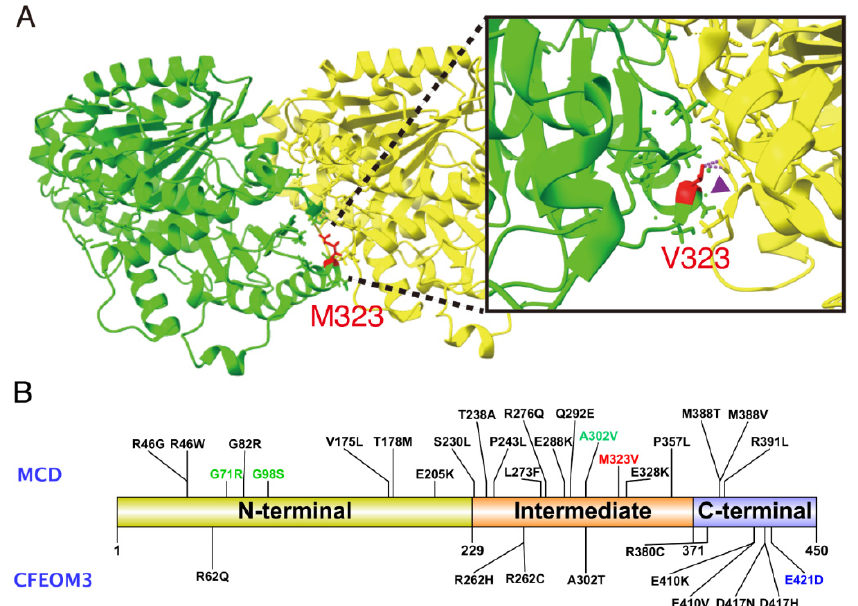
Figure 3. ( A ) A protein model with UCSF ChimeraX, showing the unstable formation of αβ tubulin heterodimer in M323V syndrome. Green, class III β -tubulin encoded by TUBB3 ; Yellow, α tubulin encoded by TUB1A1 . A clash occurred between TUBB3 :p.V323 and TUBA1A:p.Y210 (arrowhead). ( B ) Schematic diagram of deleterious variants in TUBB3 functional domains. A total of thirty-two missense variants, including p.M323V, have been reported until recently. Variants associated with malformations of cortical development (MCD) with or without congenital fibrosis of the extraocular muscles type 3 (CFEOM3) are marked above, and variants only representing CFEOM3 are marked at the bottom. Most variants in the N-terminal and the intermediate domain cause MCD, and missense variants in the C-terminal cause either MCD or CFEOM3 phenotypes. A red word indicates the variant in this study. Green words denote previously reported variants associated with infantile nystagmus, and a blue word indicates a variant associated with monocular elevation deficiency.